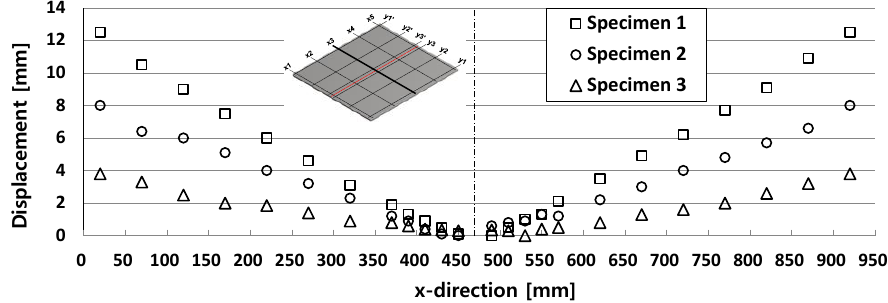
Figure 8. Experimental results of horizontal welding deformations (line